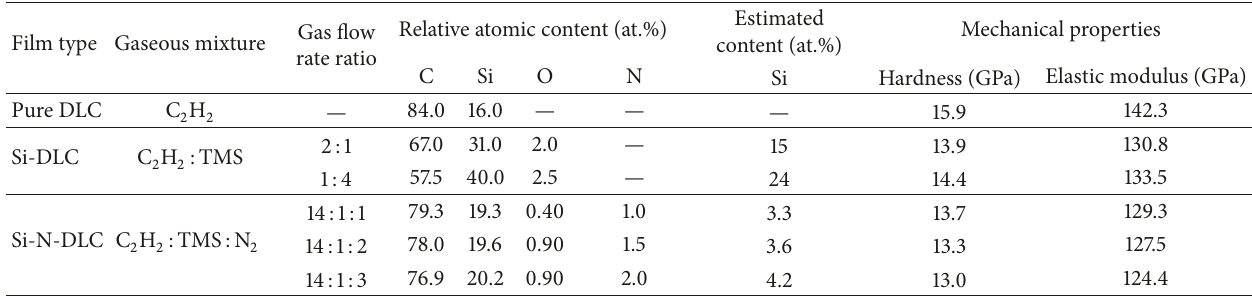
Table 3: Relative atomic content and mechanical properties of all films.